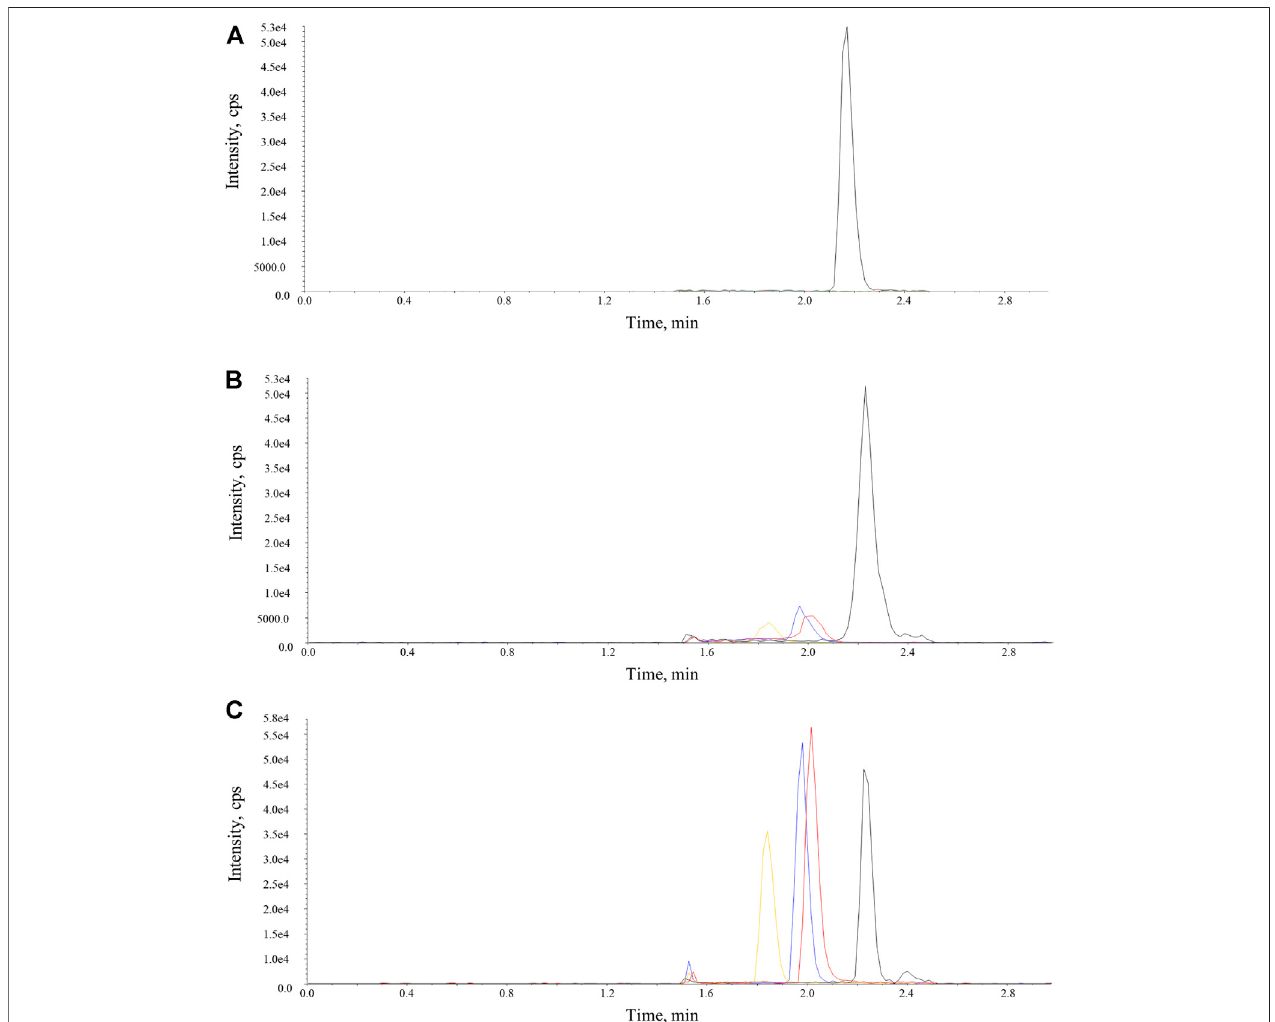
FIGURE 4 | Representative chromatograms of osimertinib, AZ-5104, AZ-7550, and IS in SD rat plasma samples. The red, orange, and blue lines represent osimertinib, AZ-5104, and AZ-7550. The black line represents IS. (A) Blank, (B) LLOQ, and (C) real SD rat plasma sample.